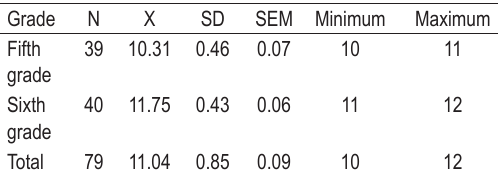
TABLE 2. Age distribution in fifth‑ and sixth‑grade